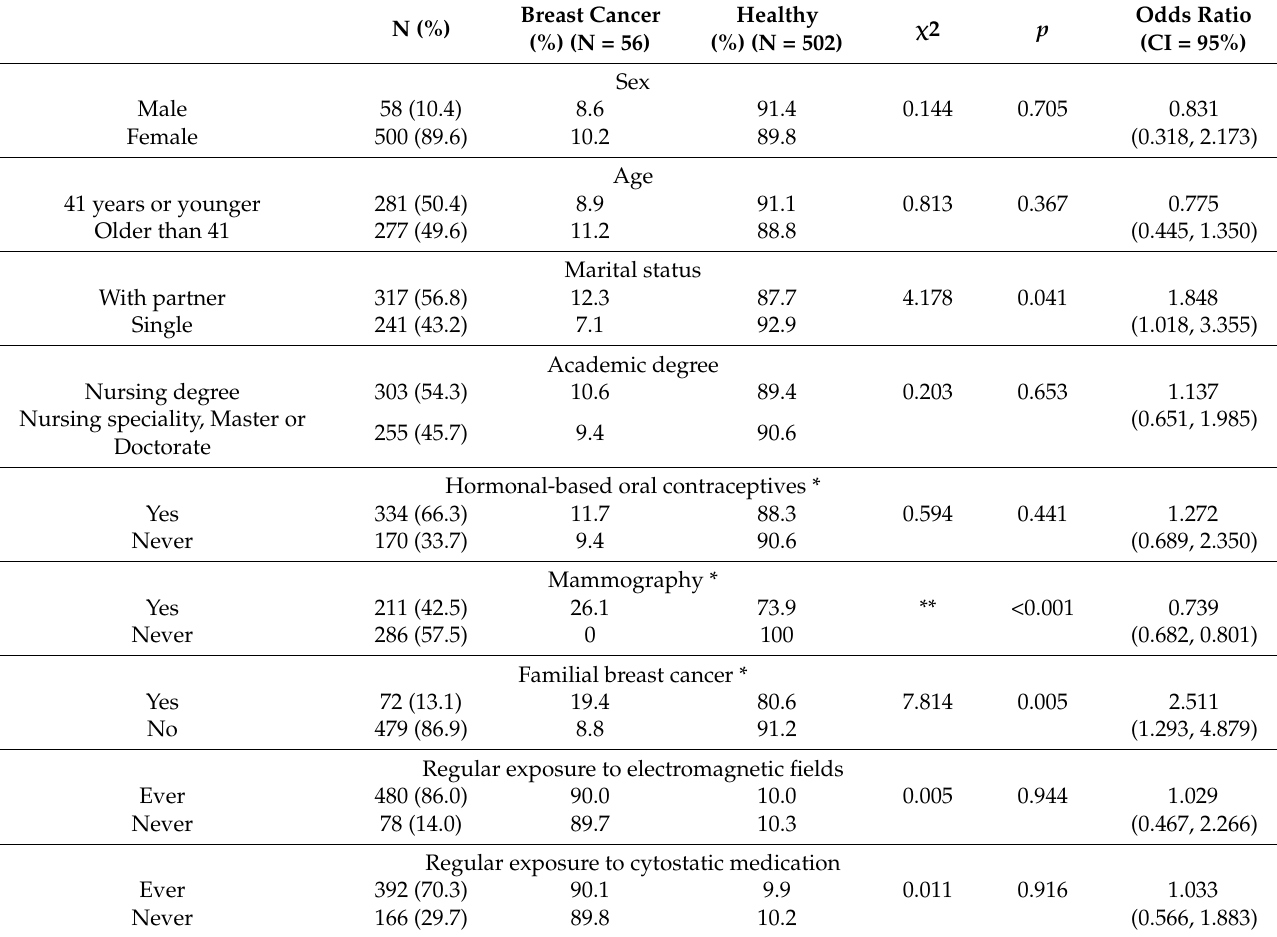
Table 2. Bivariate analysis of risk variables between healthy nurses and nurses with breast cancer (N =